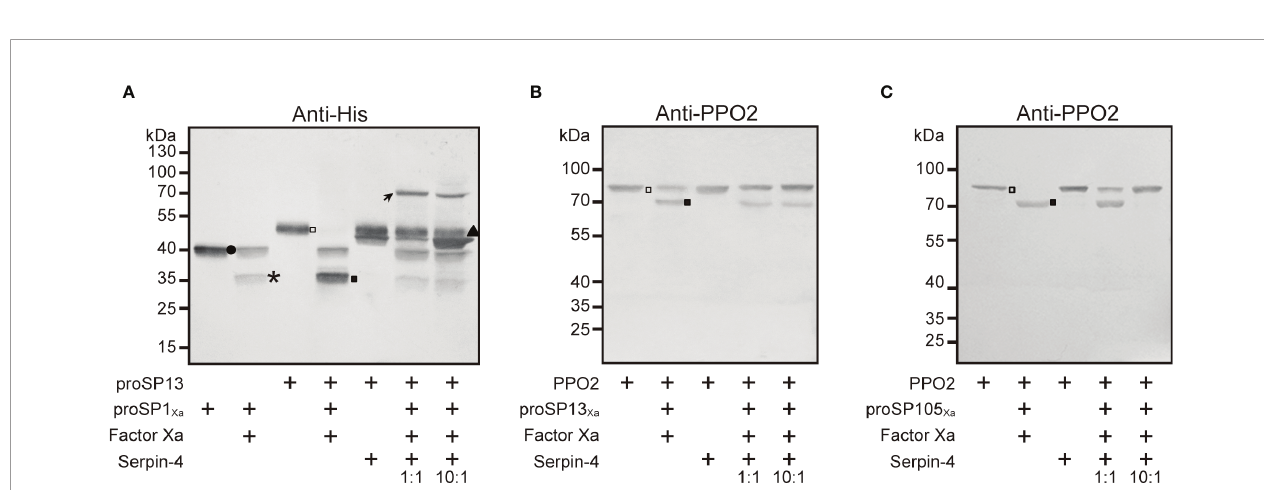
FIGURE 6 | Serpin – 4 prevented SP1 (A) , SP13 (B) or SP105 (C) from cleaving its respective downstream protease. Factor Xa – activated SP Xa (200 ng) was combined with a 1- or 10-fold molar excess of serpin – 4 and then incubated with recombinant proSP13 (200 ng) or OfPPO2 (200 ng) at 37°C for 15 min. The mixtures were subjected to 10% or 7.5% SDS – PAGE and immunoblotting using antiserum against His or PPO2. Circle, proSP13Xa; asterisk, catalytic domain of proSP1 Xa , proSP13 Xa or proSP105 Xa ; triangle, serpin – 4; hollow square, proSP13 or PPO2 zymogen; solid square, activated SP13 or PO2.